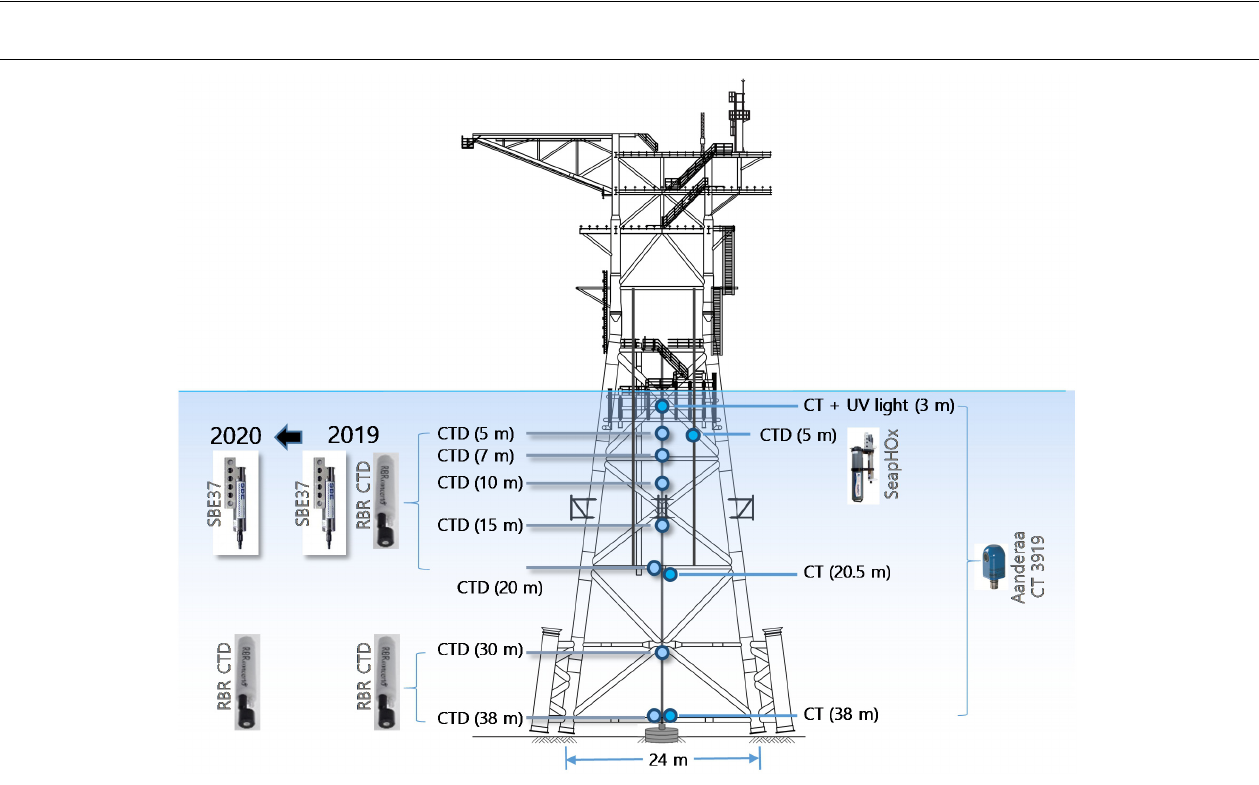
FIGURE 8 | Schematic mounting location diagram of oceanic sensors installed at Ieodo ORS. RBR concerto CTDs, SEB37-SI CTDs, and a SeapHOx with SBE37-SMP CTD are moored during the stratification season from late May to October, whereas Aanderaa CTs are installed for the entire year. Note that the RBR CTDs concurrently operated with the SBE37-SI CTDs at depths ≤ 20 m were installed in 2019 and removed in May 2020.